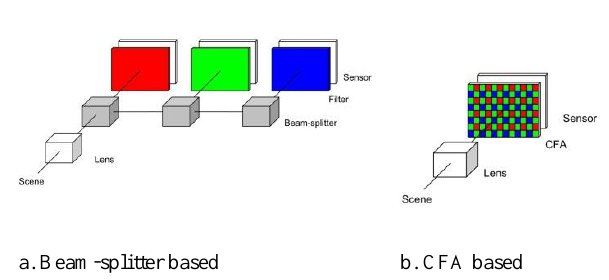
Figure 1. RGB imaging sensors